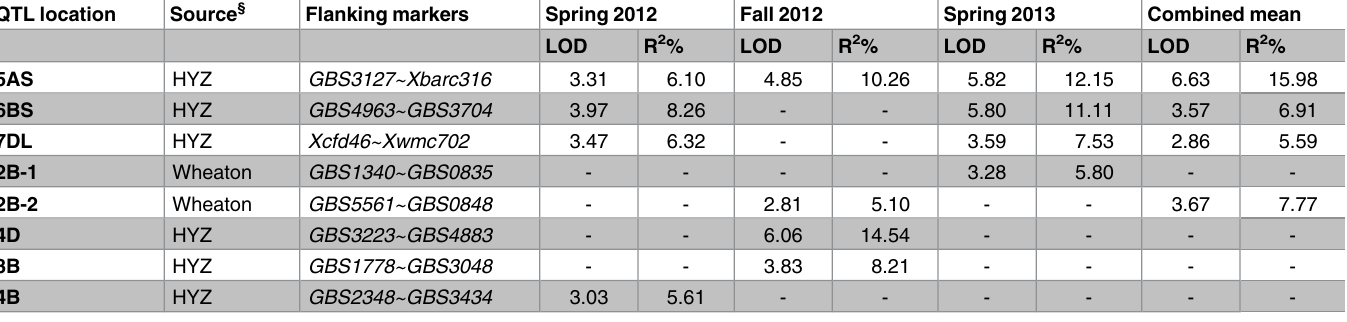
Table 1. Flanking markers, logarithm of odds (LOD) values, coefficients of determination (R 2 ) of the significant QTLs detected by inclusive com- posite interval mapping using the FHB severity data collected from spring and fall 2012, and spring 2013 greenhouse. QTL